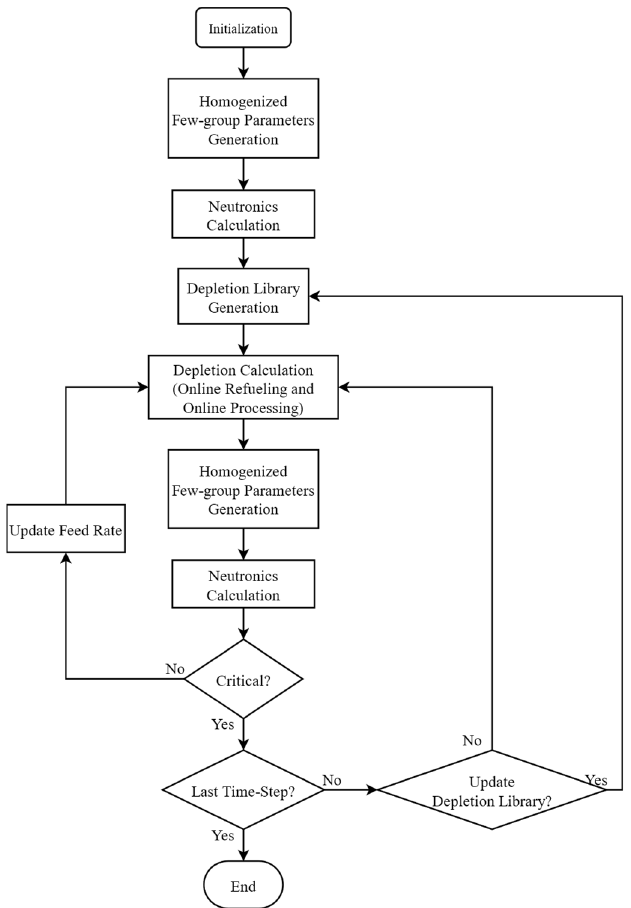
Figure 1. Flowchart of the ThorNEMFM code.